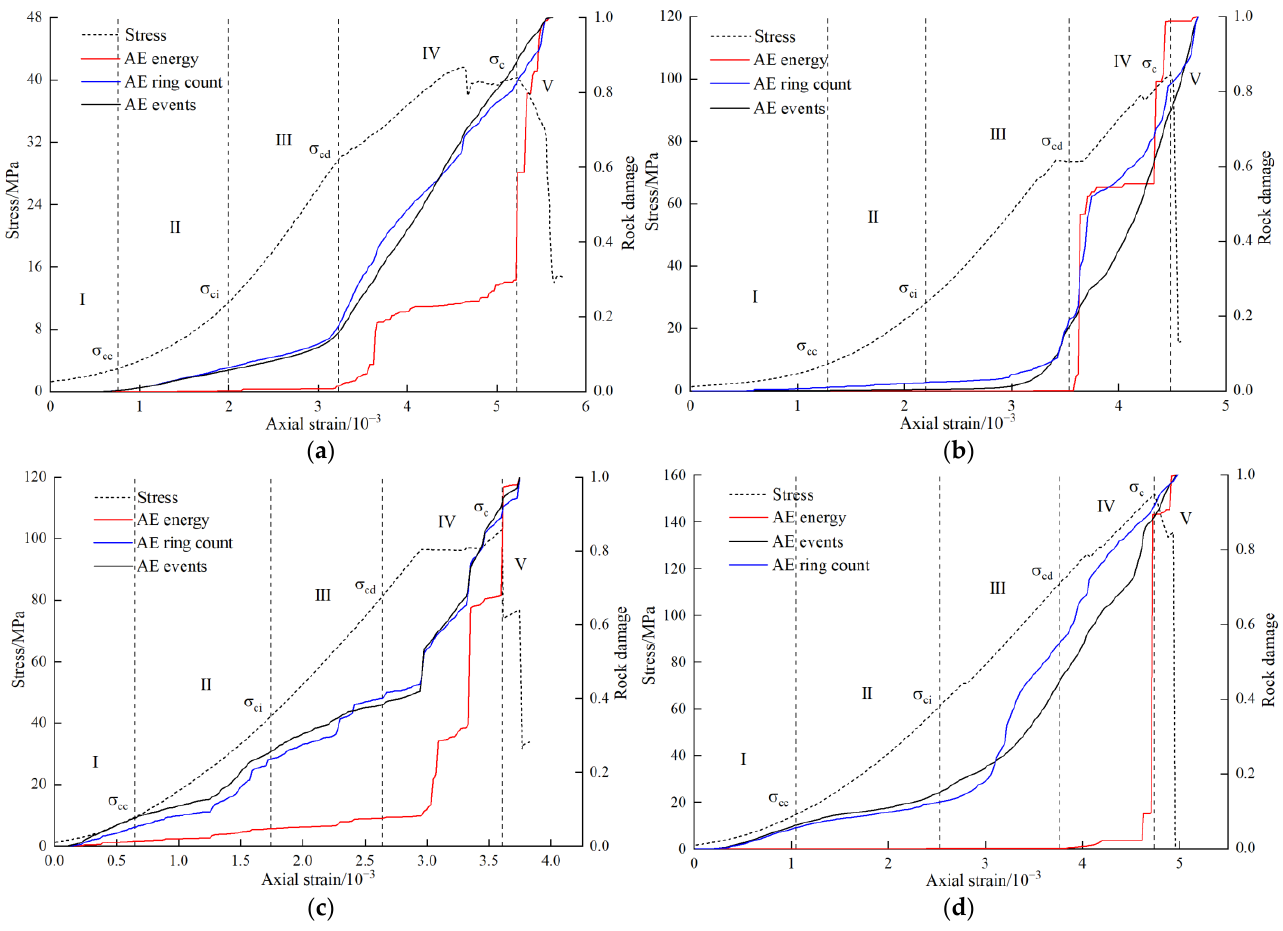
Figure 6. Damage changes represented by different AE parameters of the limestone. ( a ) The limestone without a rockburst tendency; ( b ) the limestone with a weak rockburst tendency; ( c ) the limestone with a medium rockburst tendency; and ( d ) the limestone with a strong rockburst tendency.